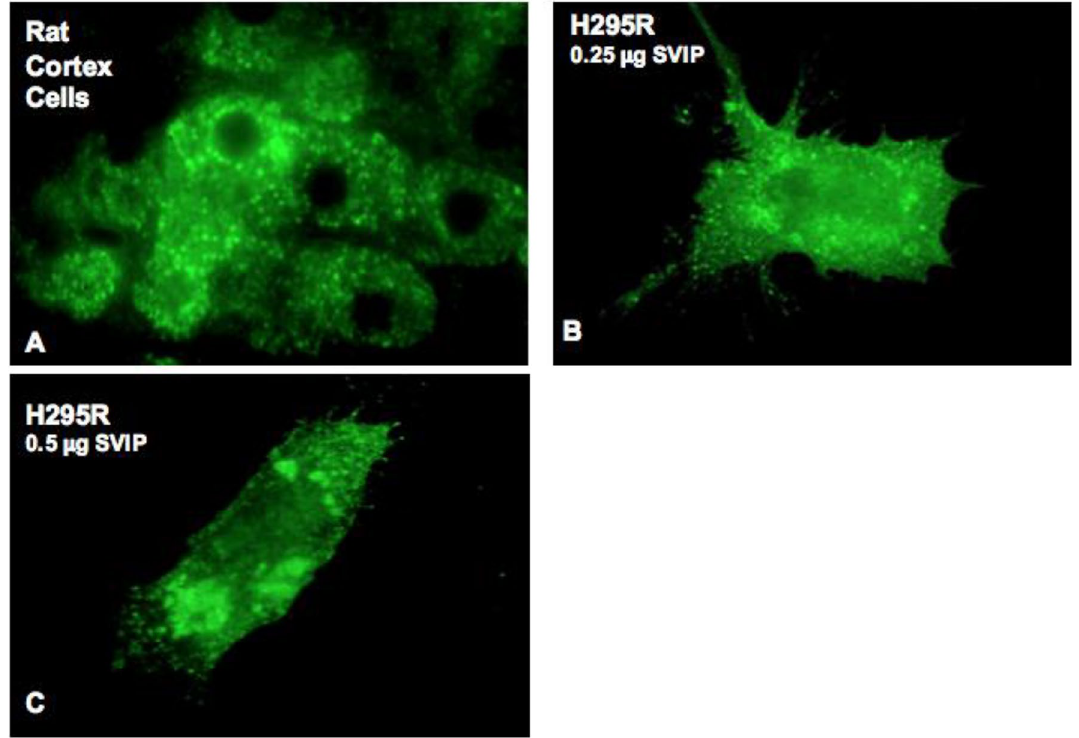
Figure 3. SVIP is localized at punctate structures as juxtanuclear vacuoles in rat adrenal cortex cells and H295R cell line. ( A ) Location of endogenous SVIP was determined in postnatal day 60 rat adrenal cortex cells by immunostaining using confocal microscopy. ( B , C ) H295R cells were transfected with ( B ) 0.25 μg or ( C ) 0.5 μg pCIneo-SVIP-His plasmid, then cells were stained with anti-His